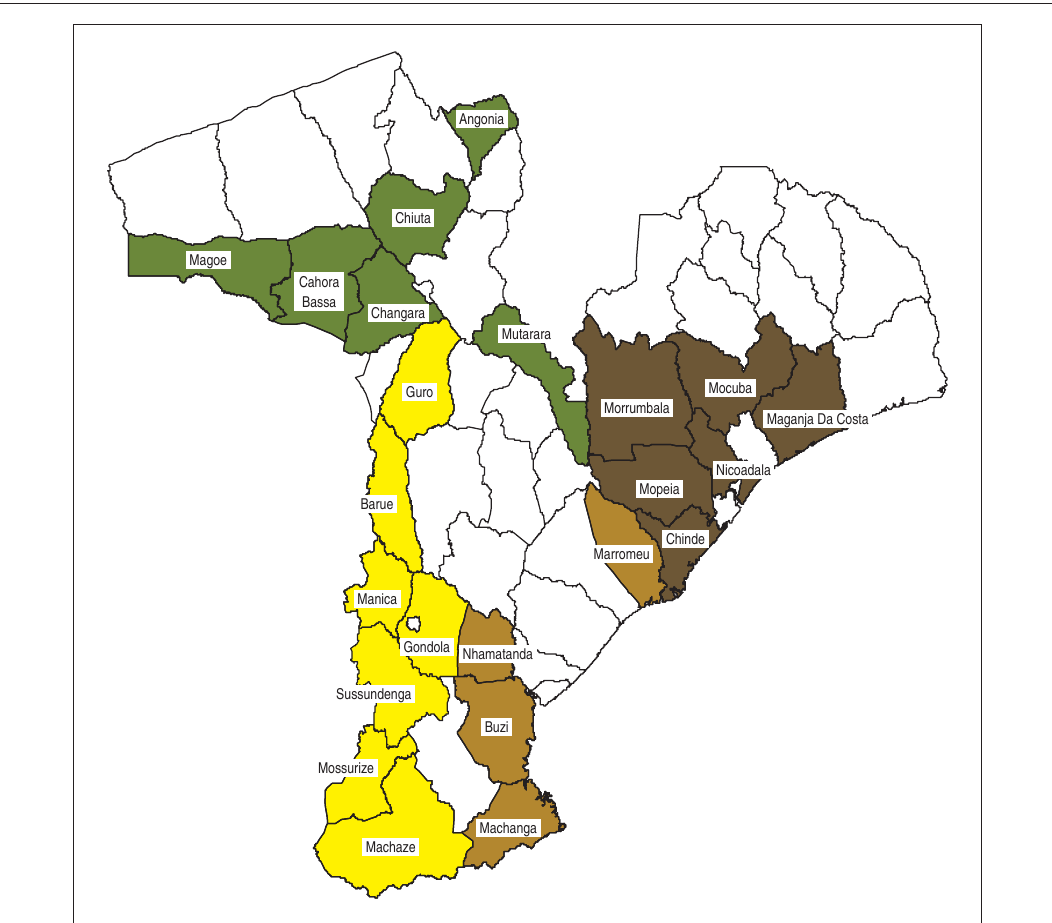
Districts sampled in Manica, Sofala, Zambézia and Tete